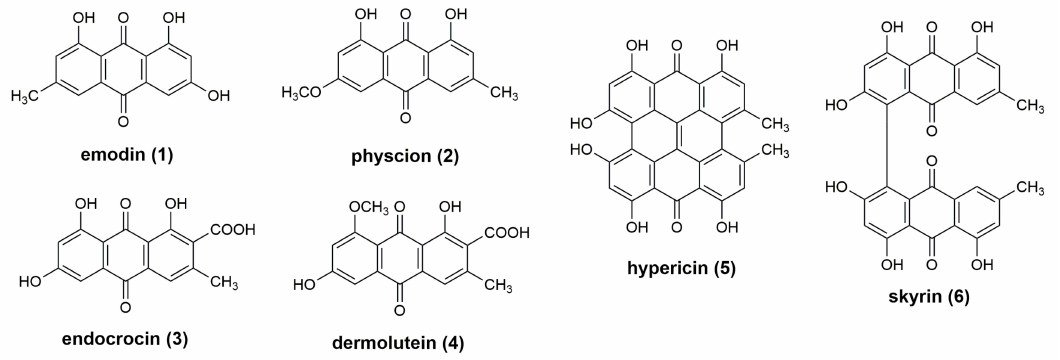
Figure 2. Structures of investigated anthraquinones 1–6